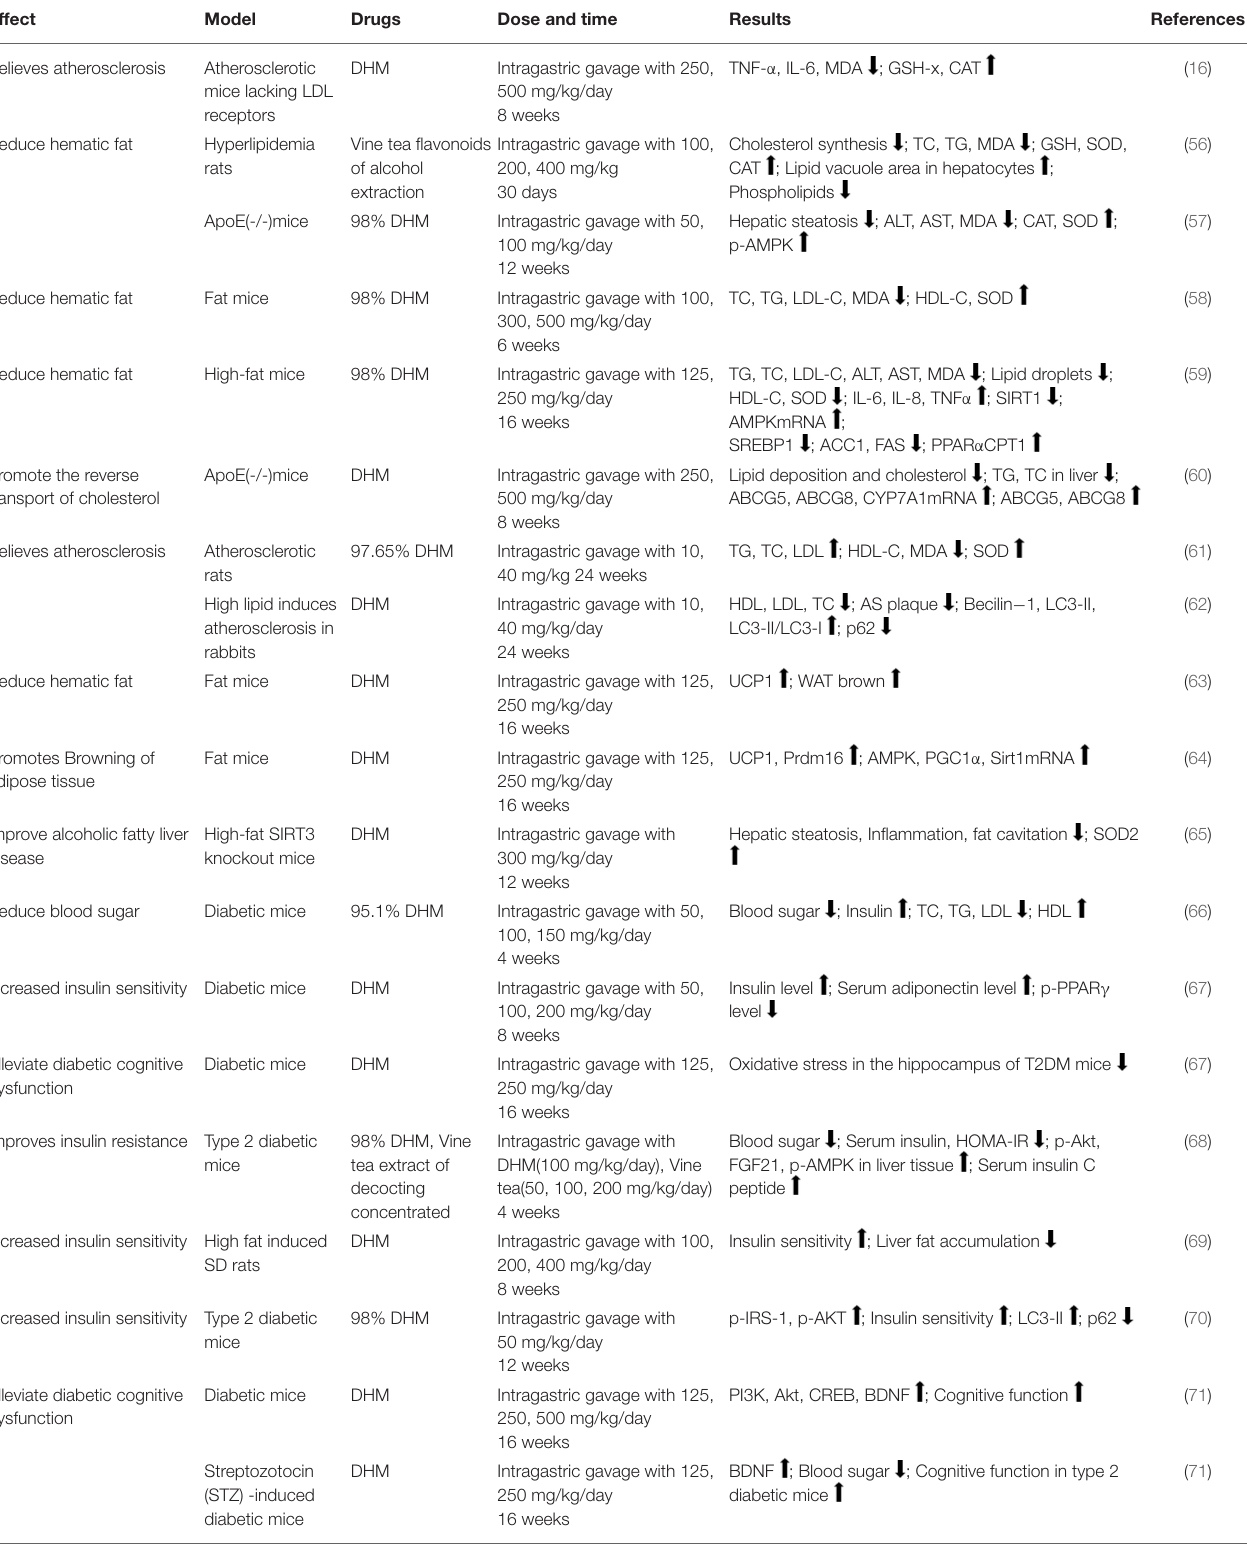
TABLE 2 | The effect and molecular mechanism of dihydromyricetin (DHM) on metabolic syndrome (MS) in